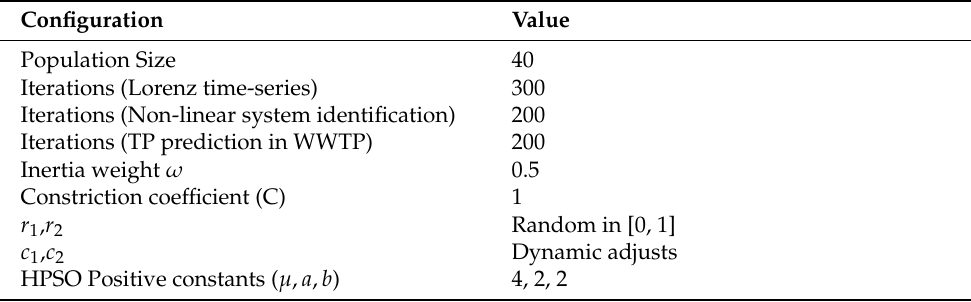
Table 1. PSO and HPSO-SSM parameter fine-tuning